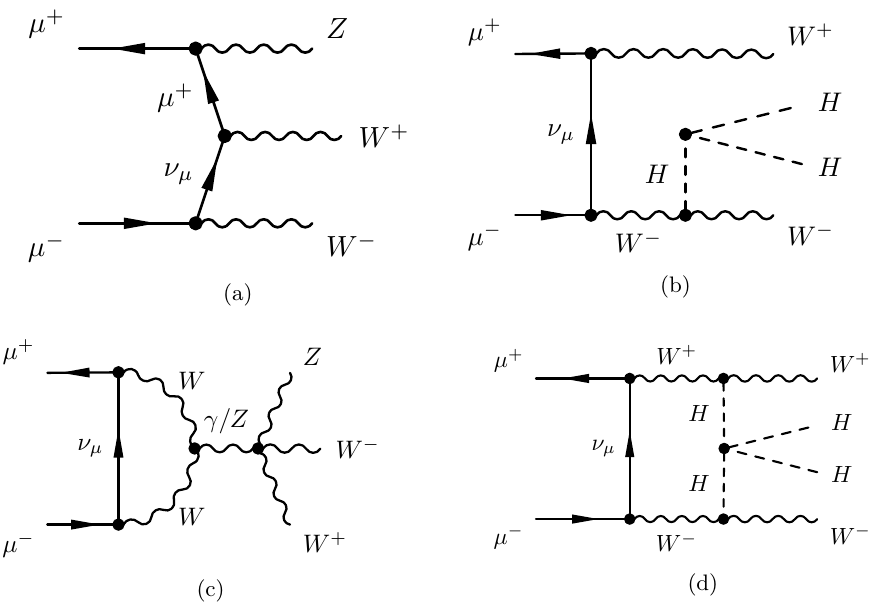
Figure 5 . Upper row: tree-level diagrams for the processes µ + µ − → W + W − Z in (a) and to µ + µ − → W + W − HH in (b), respectively. Lower row: representative one-loop diagrams for the virtual contribution to µ + µ − → W + W − Z in (c) and to µ + µ − → W + W − HH in (d), respectively.